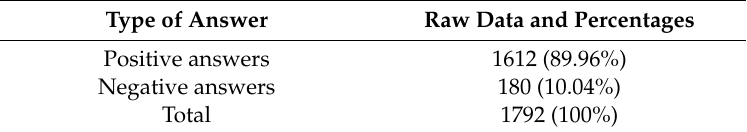
Table 1. Distribution of the answers given by executive employees in raw data (and % between brackets).